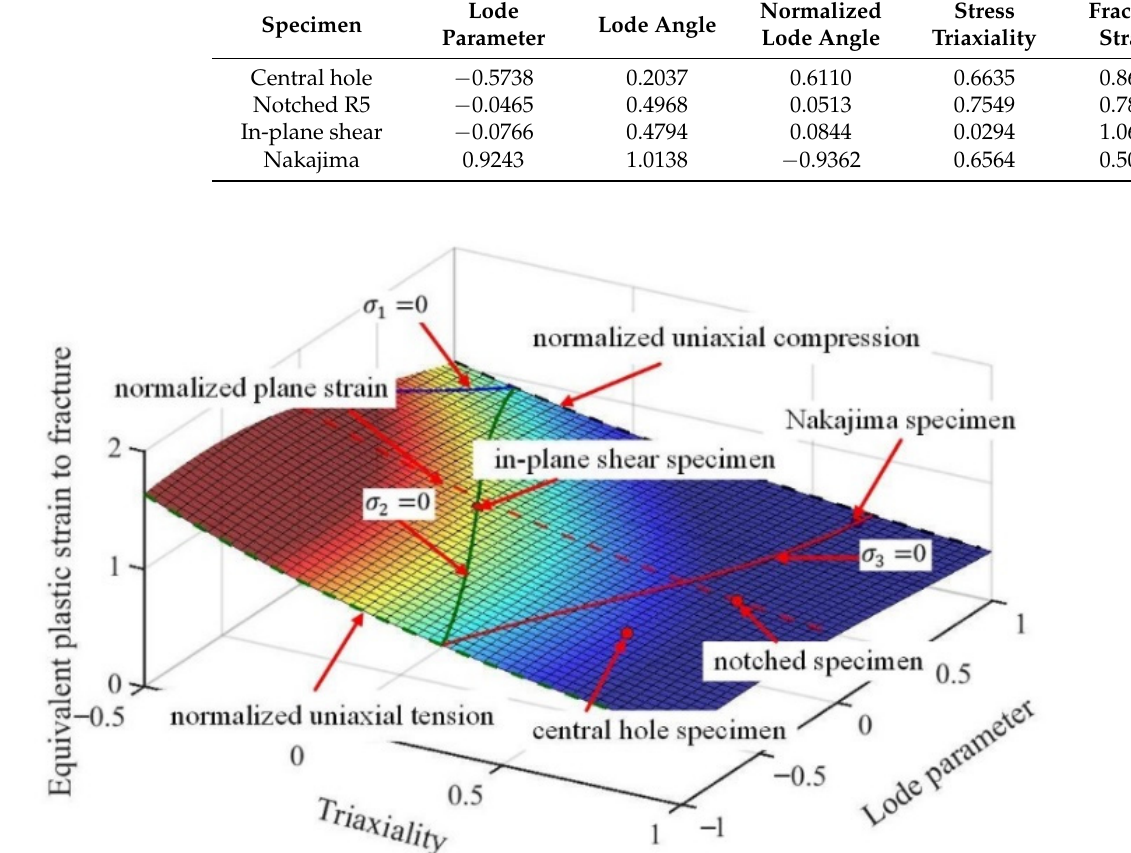
Figure 18. Fracture locus constructed based on the obtained fracture strains in different stress states and compared with experimental data for 80%B + 20%M specimens (red dots denote experimental values).